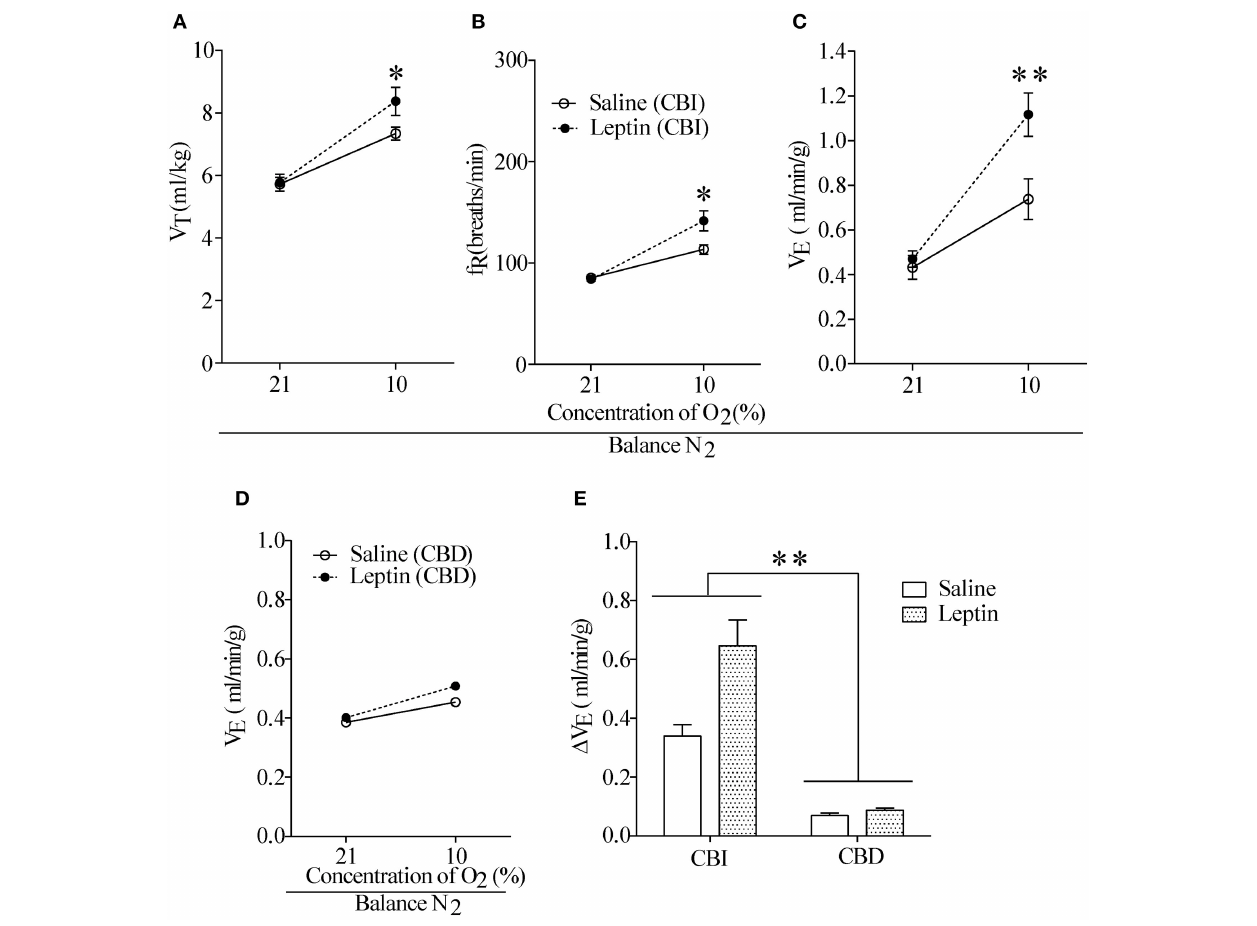
FIGURE 3 | Effect of hypodermic injection of Leptin on breathing parameters. (A–C) Injection of leptin raised V T , f R , and V E measured on 7th day in the LZR with CBI. (D) The stimulatory effect of hypoxia was reduced in two groups of rats with CBD. (E) Changes in V E during exposure to 10% O 2 in CBI and CBD groups. n = 8 for each group, * P < 0.05, ** P < 0.01 by two-way ANOVA with Bonferroni post-hoc test, Leptin vs. Saline group.